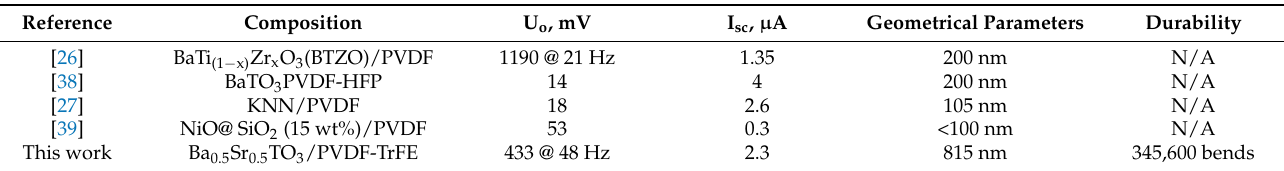
Table 3. A comparative table for the main electrical parameters, considering the thickness of the incorporated piezoelectric film or